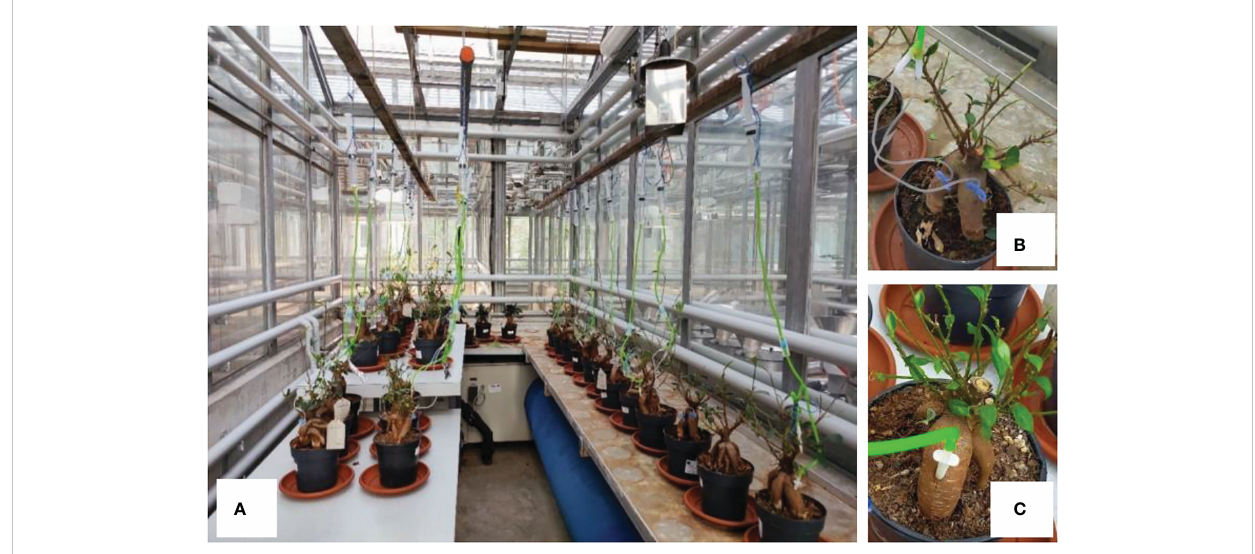
FIGURE 1 Glucose infusion experiment with Ficus microcarpa bonsai plants in WSL greenhouse (A) . Each of the three treatments, i.e. phloem infusion (B) , xylem infusion (C) , and control, had 9 plants. The infusion set consists of a 20 mL-syringe, a 120 cm-long rubber tube with a fl ow regulator and two thin infusion needles for phloem infusion (B) , or one thick plastic needle for xylem infusion (C)